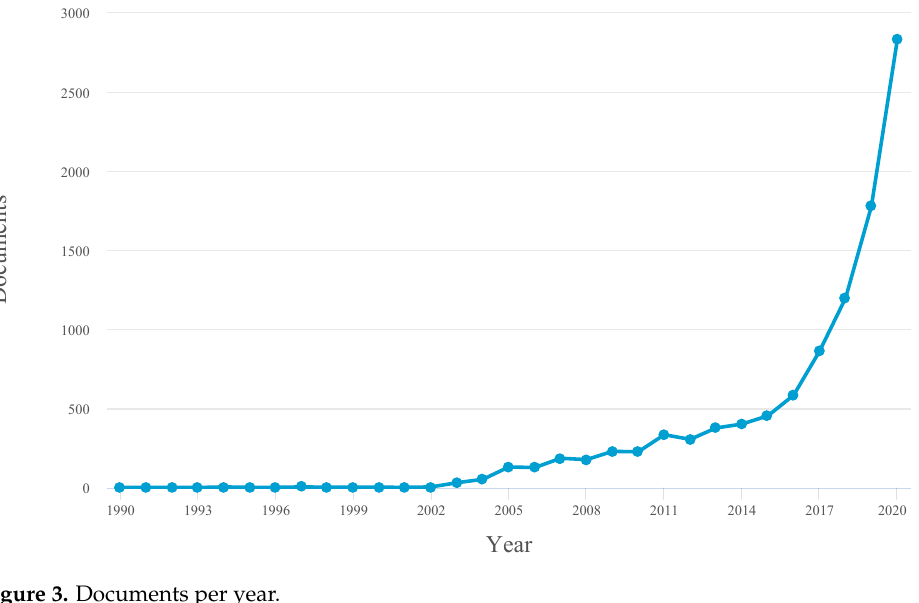
Figure 3. Documents per year.